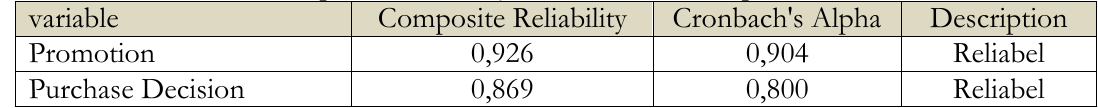
Table 6 Composite Reliability and Cronbach's Alpha Test Results